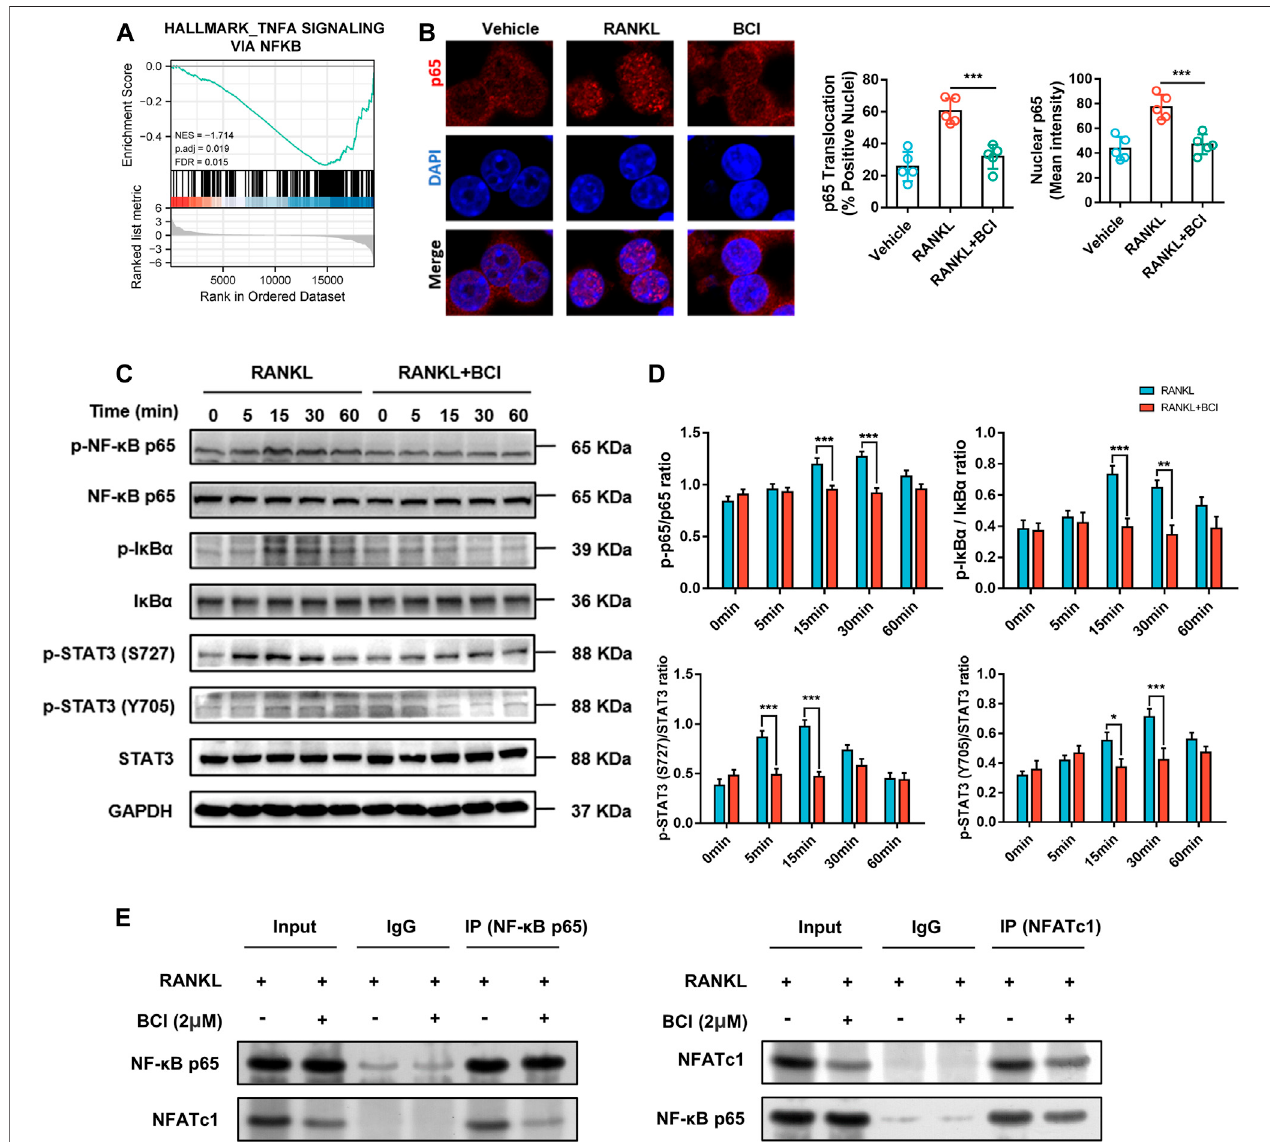
FIGURE 5 | BCI suppresses RANKL-induced osteoclastogenesis via inhibiting NF- κ B – NFATc1 interaction. (A) GSEA results showing altered TNF- α signaling via NF- κ B expression and activation (adjusted p (cid:2) 0.019; FDR q -value (cid:2) 0.015). (B) Immuno fl uorescence staining of p65 during RANKL-induced osteoclastogenesis and with or without BCI treatment. (C,D) Western blot and corresponding quanti fi cation results showing levels of I κ B α , p-I κ B α , p65, p-p65, STAT3, and p-STAT3 at various timepoints (0, 5, 15, 30, and 60 min) in the control and BCI-treated groups. (E) Co-IP to assess NF- κ B/p65 interaction with NFATc1. GAPDH was selected as the internal reference. * p < 0.05, ** p < 0.01, *** p < 0.001.